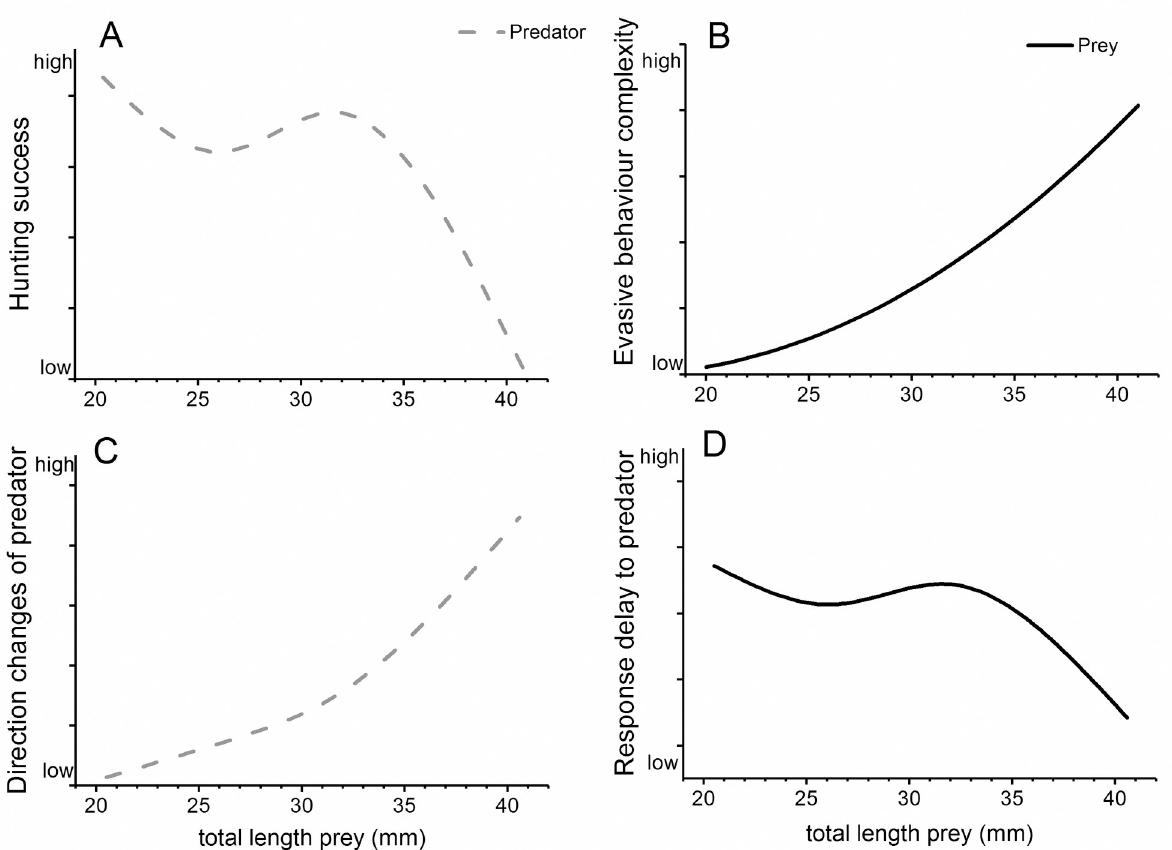
Fig 9. Projected predator and prey relationships. Summary of the observed relationships between predator (stickleback) and prey (whitefish) behaviour at different prey length classes: A) Hunting success of sticklebacks decreases with prey size, which was shown to be correlated to B) an increase in complexity of predator avoidance behaviours. A and B are based on previously published data from the same experiment [33]. The current study indicates that: C) predators more often adjust their swimming direction when following larger whitefish larvae; D) larger whitefish are increasingly adept at detecting the start of the hunt as measured by an increase in swimming speed; B+D could explain why predators increasingly need to adjust their track C) which in turn might decrease hunting performance (A).